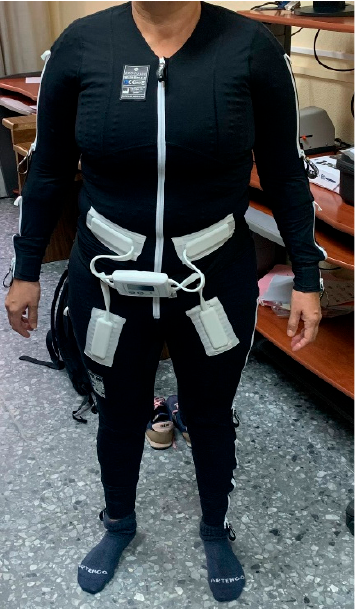
Figure 2. Mollii Control Unit [30].